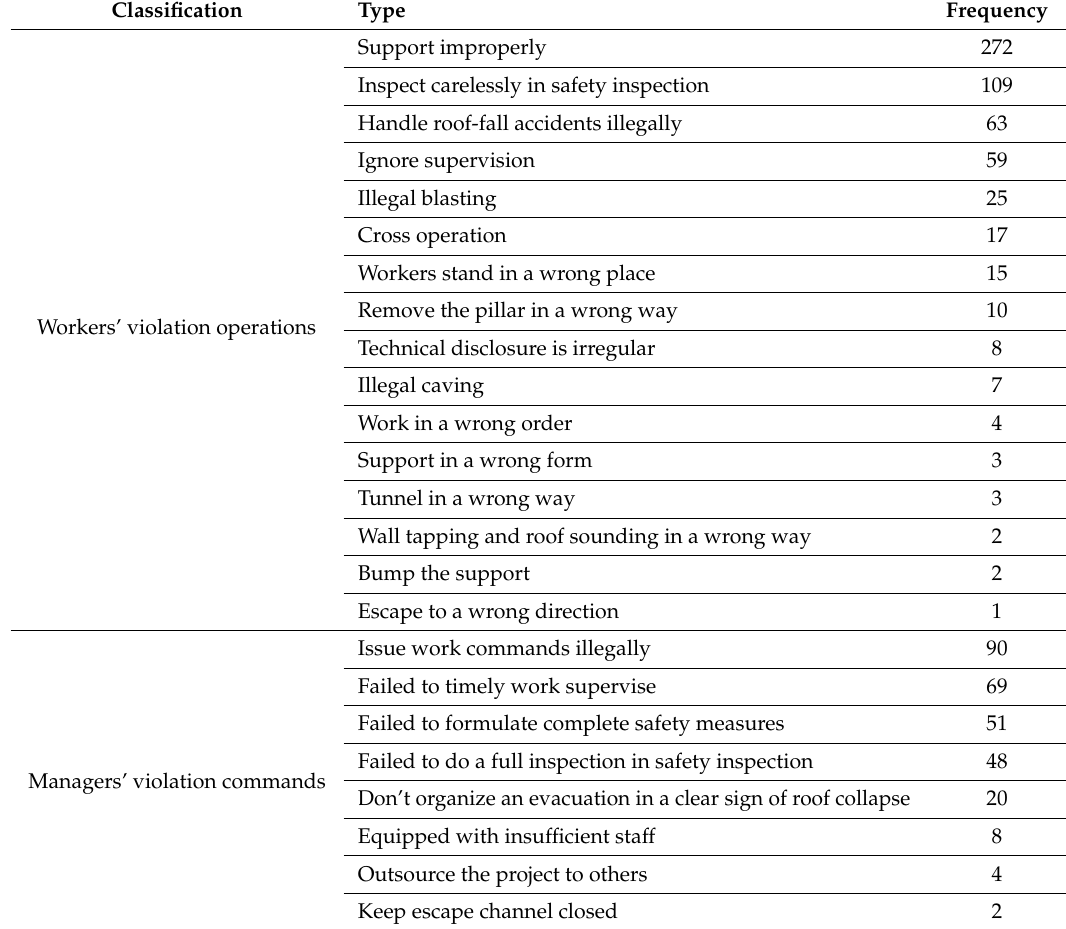
Table 1. Unsafe behavior